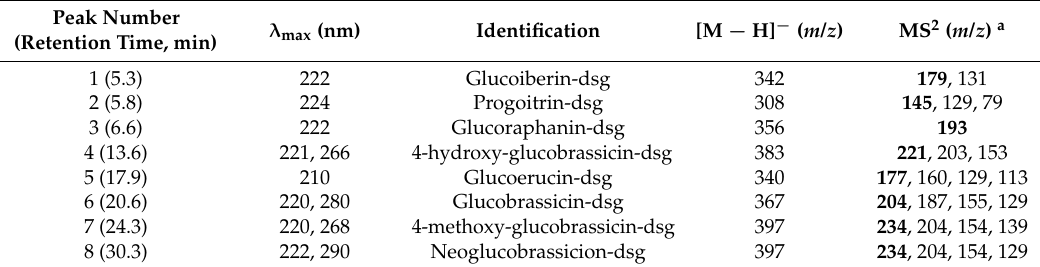
Table 1. Identification of individual desulfoglucosinolates (dsg) in broccoli sprouts. Identification was obtained by HPLC-DAD and HPLC-Electrospray Ionization (ESI)-Sequential Mass Spectrometry (MS n ). Peak Number (Retention Time, min)